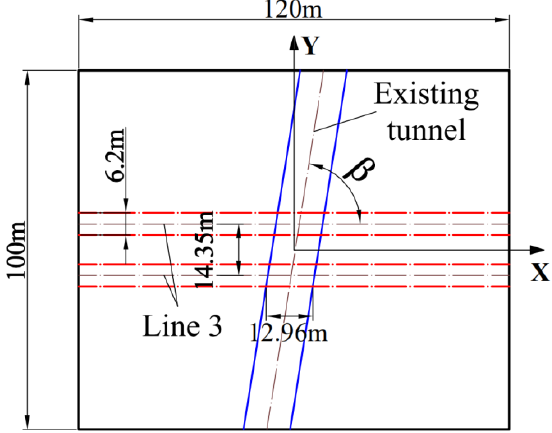
Figure 18. Numerical simulation model diagram.